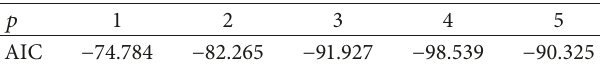
Table 7: Different p value AIC sizes.